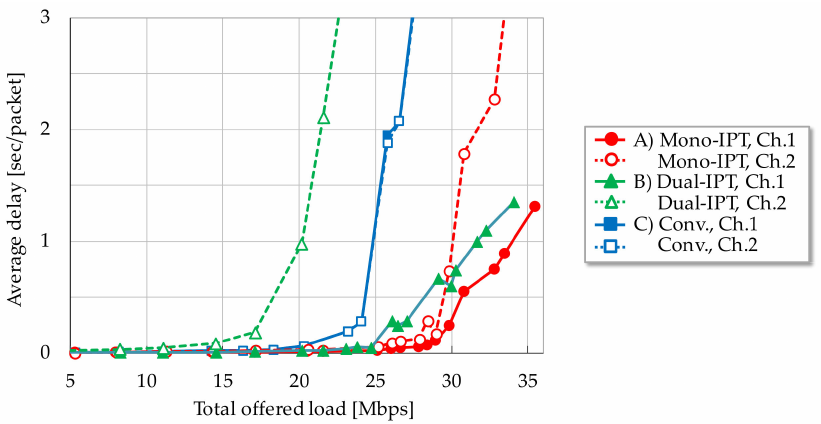
Figure 10. Average packet delay for each channel.